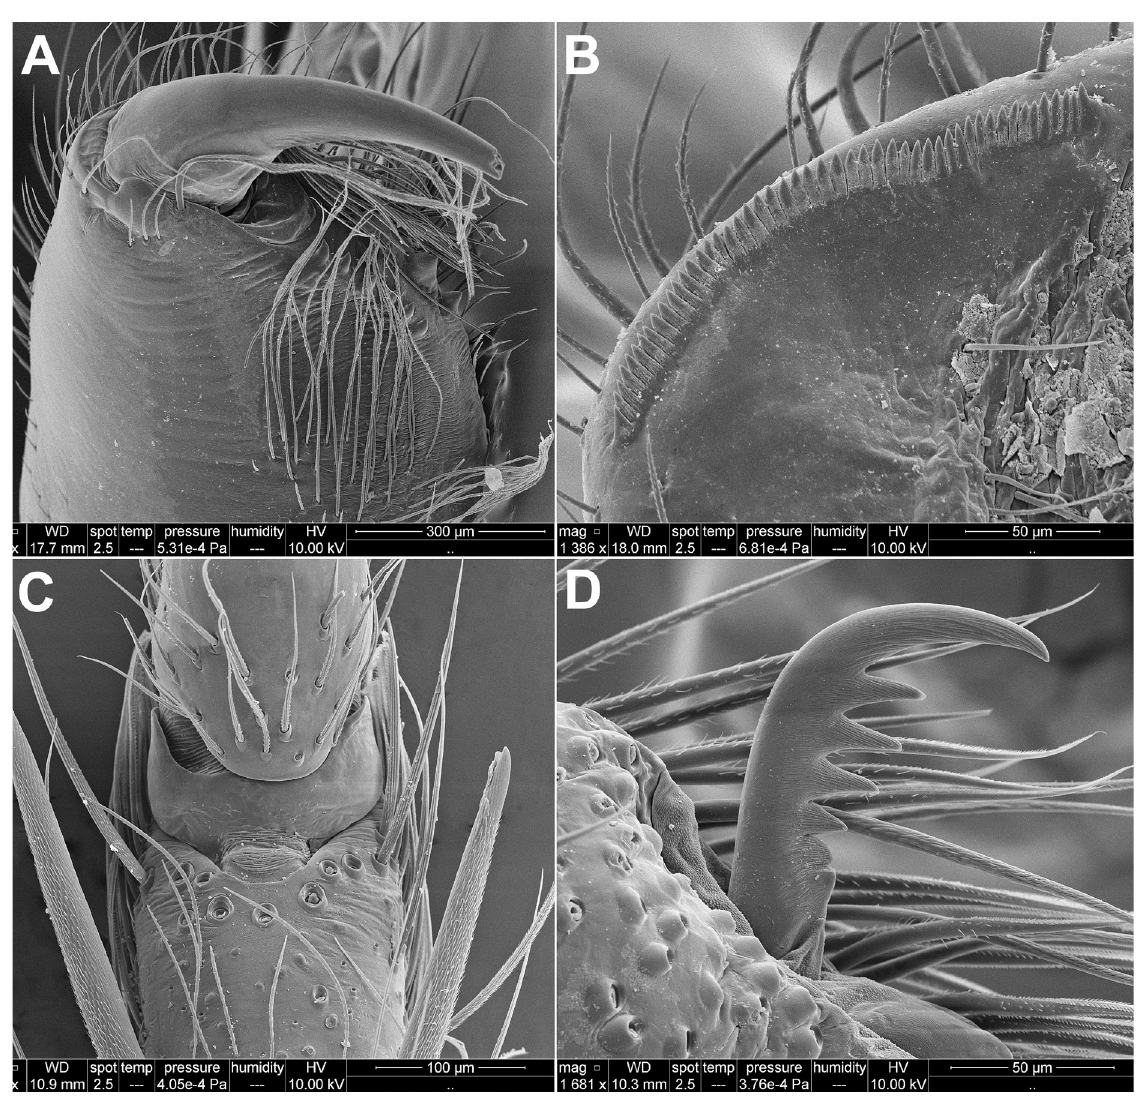
Fig. 1. Cuiambuca vacabrava sp. nov. A − B , D . Paratype, ♀ (IBSP 60015). C . Holotype, ♂ (IBSP 60013). A . Chelicerae, right, ventral view. B . Serrula, right, ventral view. C . Leg I, metatarsus, trilobate membrane, dorsal view (median hook not visible) . D . Palp, right,